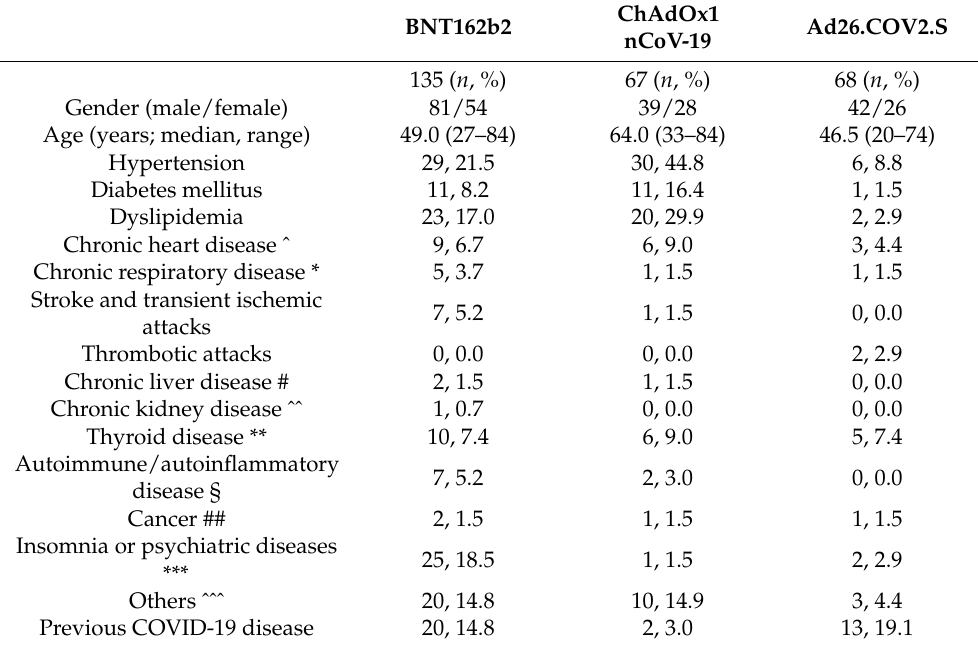
Table 1. Overview of demographic and clinical data of SARS-CoV-2 vaccinated